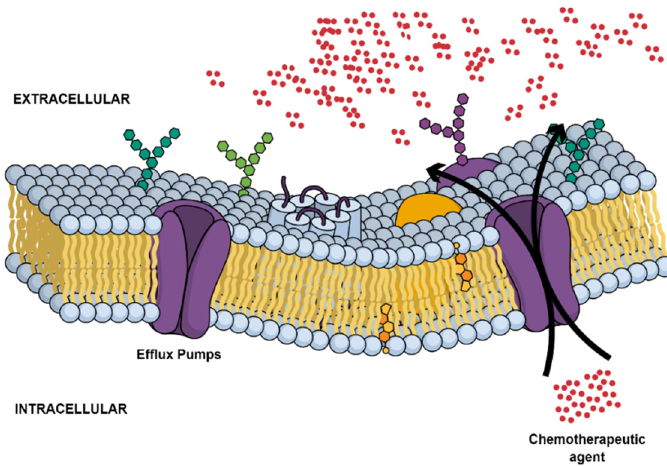
Figure 3. Drug efflux from the intracellular compartment of cancer